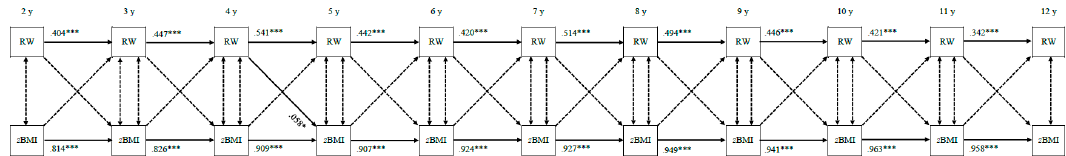
Figure 3. Bi-directional associations between food as reward and standardized child body mass index.